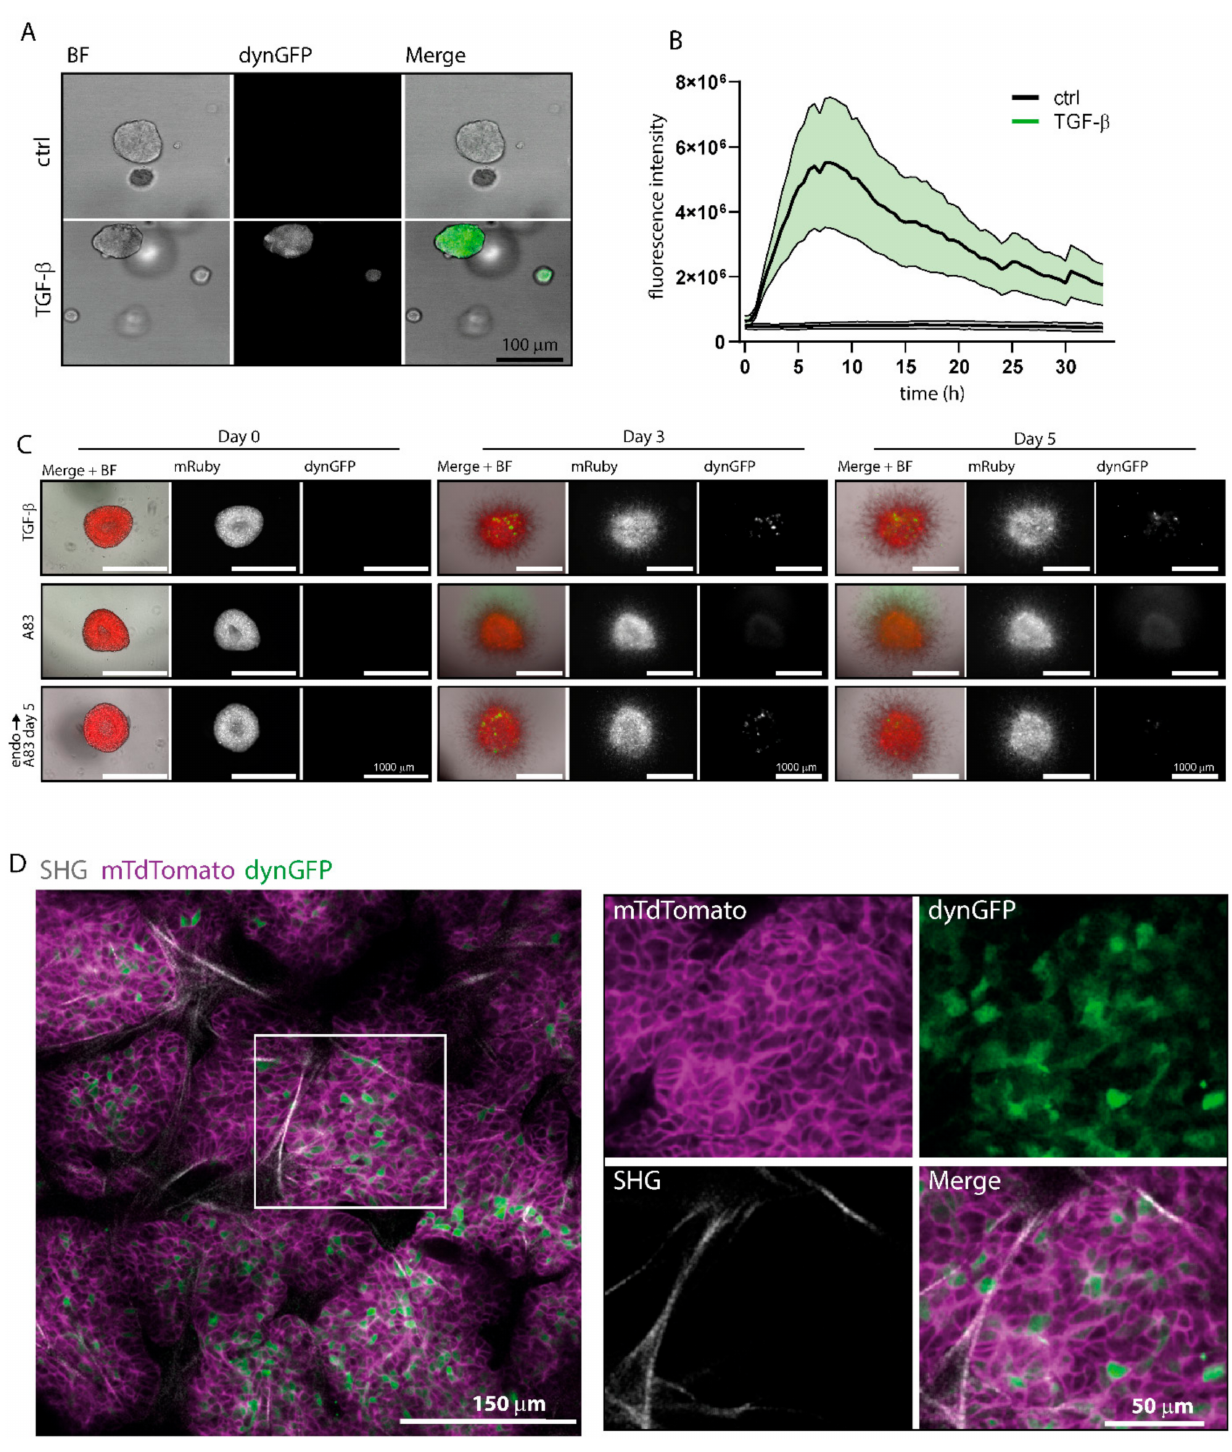
Figure 4. ( A ) Colorectal cancer organoids, P26T, were stimulated with TGF- β (1 ng/mL) for 7 h. Stimulated organoids show an increase in dynGFP signal. ( B ) Quantified dynGFP signal of A) ± SEM (in green) of control ( n = 4) and TGF- β treated ( n = 10) organoids. ( C ) Immortalized fibroblasts, RLT- PSCs, expressing H2B-mRuby and CAGA 12 -dynGFP were selected for CAGA 12 -dynGFP transduction through puromycin selection and FACS sorting. Co-cultures of RLT-PSC fibroblasts with PDAC organoids were stimulated with TGF- β 1 (5 ng/mL), A83-01 (500 nM), or endogenous conditions up to 5 days. Upon TGF- β stimulation, dynGFP expression in some RLT-PSCs was observed. Upon 3 days of culturing in endogenous conditions, dynGFP expression could be found in RLT-PSCs located in